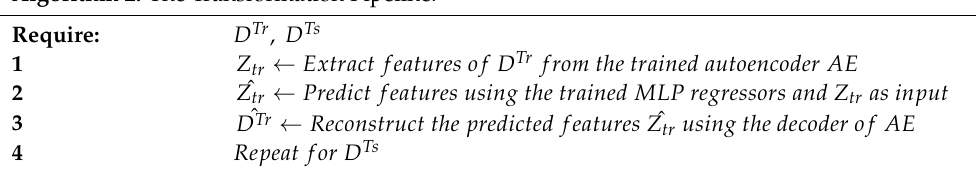
Algorithm 2. The Transformation